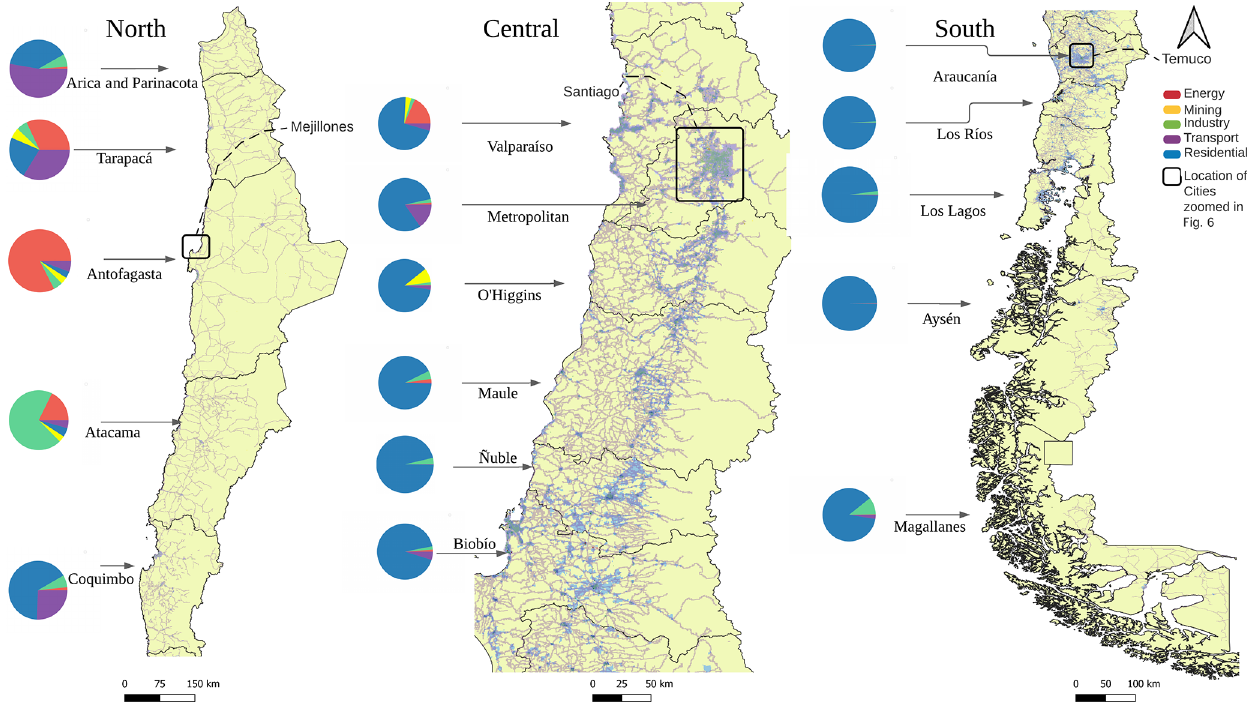
Figure 5. Spatial distribution of the 2017 emissions of PM 2 . 5 from the energy (red), industry (green), residential (blue) and transport (purple) sectors in a grid of 0 . 01 ◦ × 0 . 01 ◦ on a map of Chile according to the macrozones defined for the country (Fig. 1). Note that Metropolitan includes the capital of Santiago and ∼ 40% of the population. The pie charts indicate the relative contribution that each source makes to total PM 2 . 5 emissions in each region.